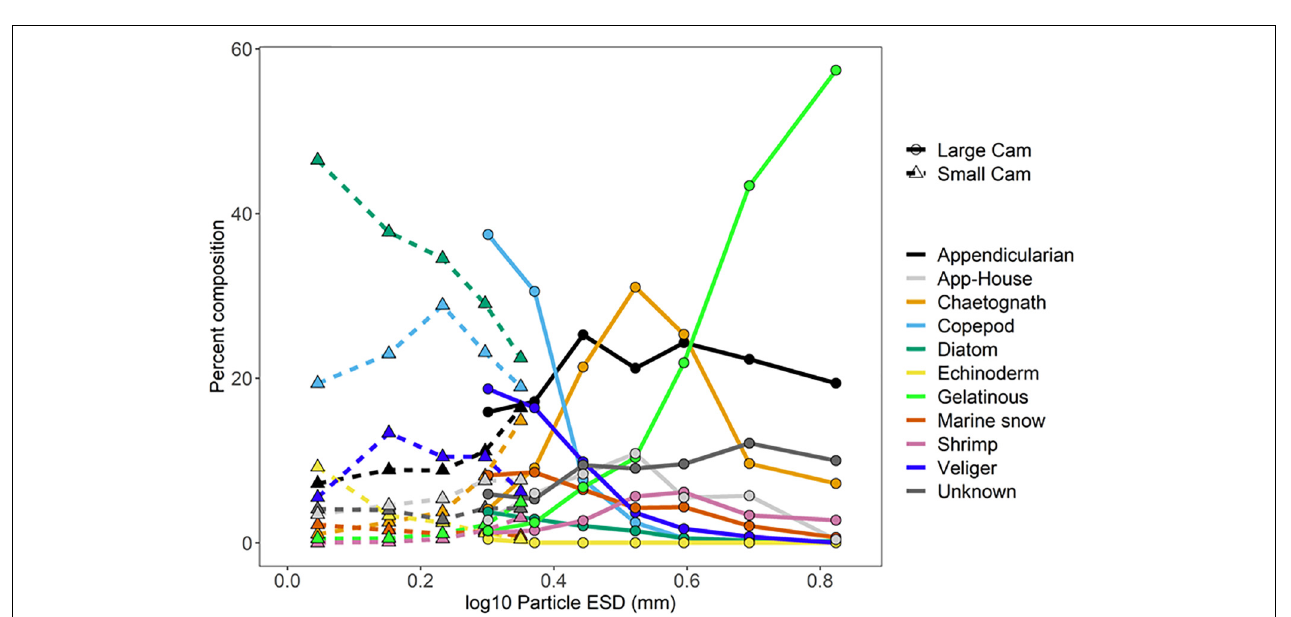
FIGURE 8 | Measured particle sizes (log10 ESD) vs. percent composition for the ISIIS small and large cameras.